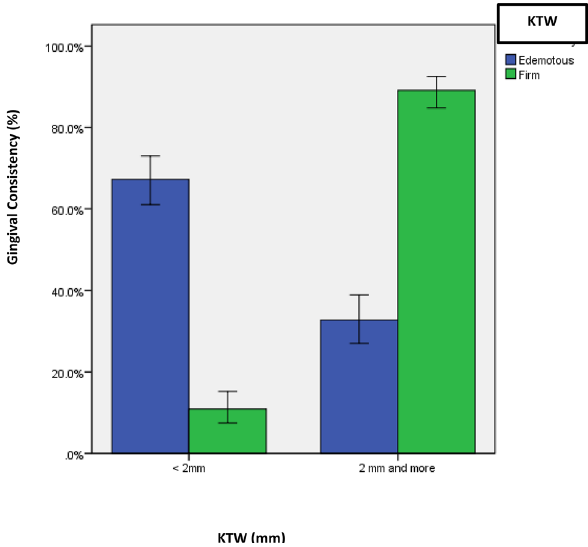
Figure 4. Percentage of gingival consistency (firm vs. edematous) based on amount of KTW.